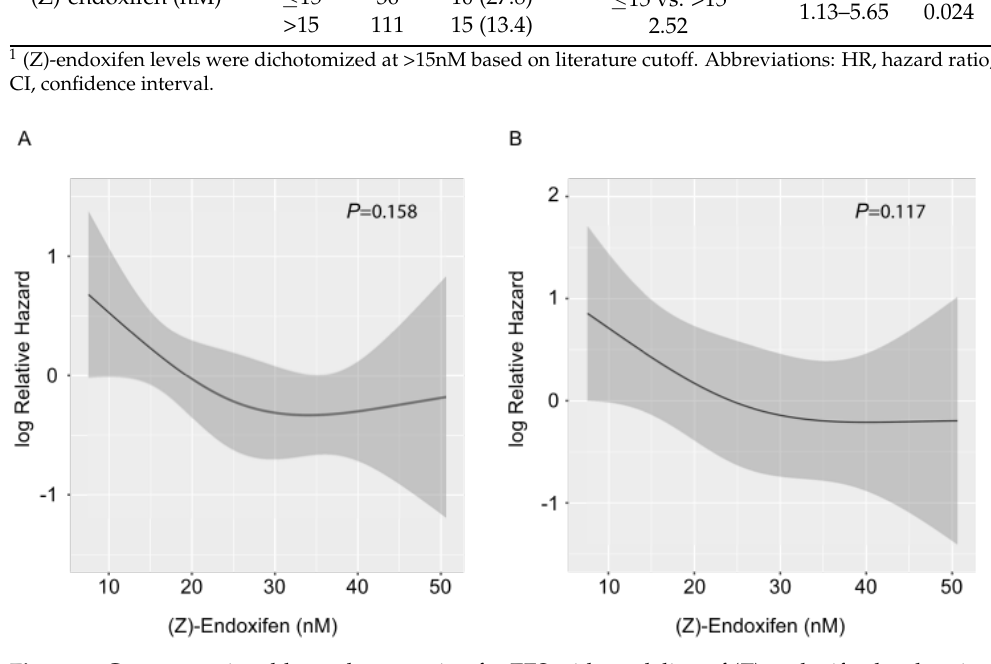
Figure 2. Cox proportional-hazards regression for EFS with modeling of (Z)-endoxifen levels using natural cubic splines (3 knots). ( A ) Univariate analysis, ( B ) multivariate analysis with adjustment for stage; 95% confidence levels are given as dark-grey shaded area.